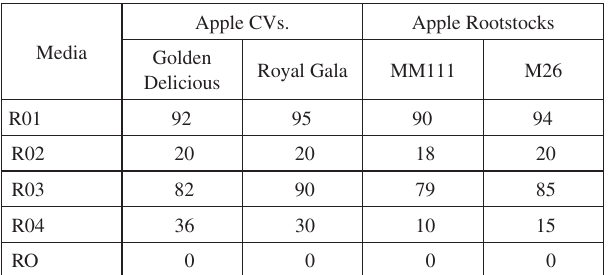
Table 3. Organogenesis/ Regeneration % in vitro in Apple cvs. and rootstocks on different media using middle part of the leaves Apple Media